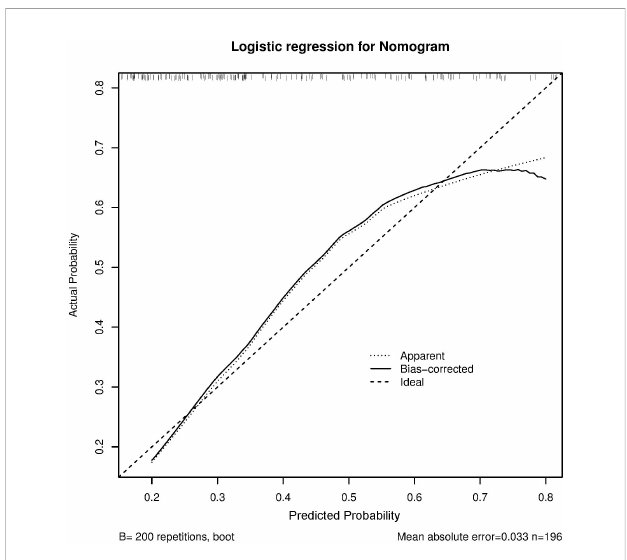
FIGURE 3 Calibration curve of non-minimal liver in fl ammation from the validation cohort.